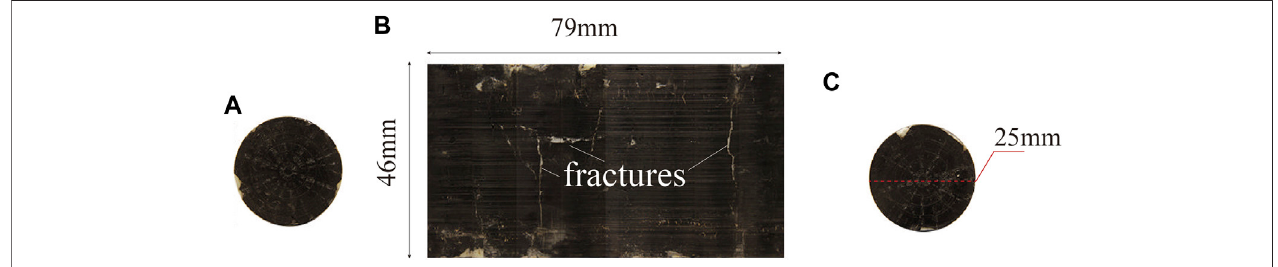
FIGURE 1 | Photograph of the sample taken after the permeability experiment, consisting of (A,C) view of two fl at ends and (B) rolled-out image of the full outer surface of the cylindrical sample (sample height = 46 mm, circumference = 79 mm). The initial fractures visible on the sample surface were fi lled with glue (white and yellow in color) to avoid failure of the sample upon employing the con fi ning pressures. Fractures without glue may be formed during the permeability experiment. Note that mechanical failure of the sample was not observed.